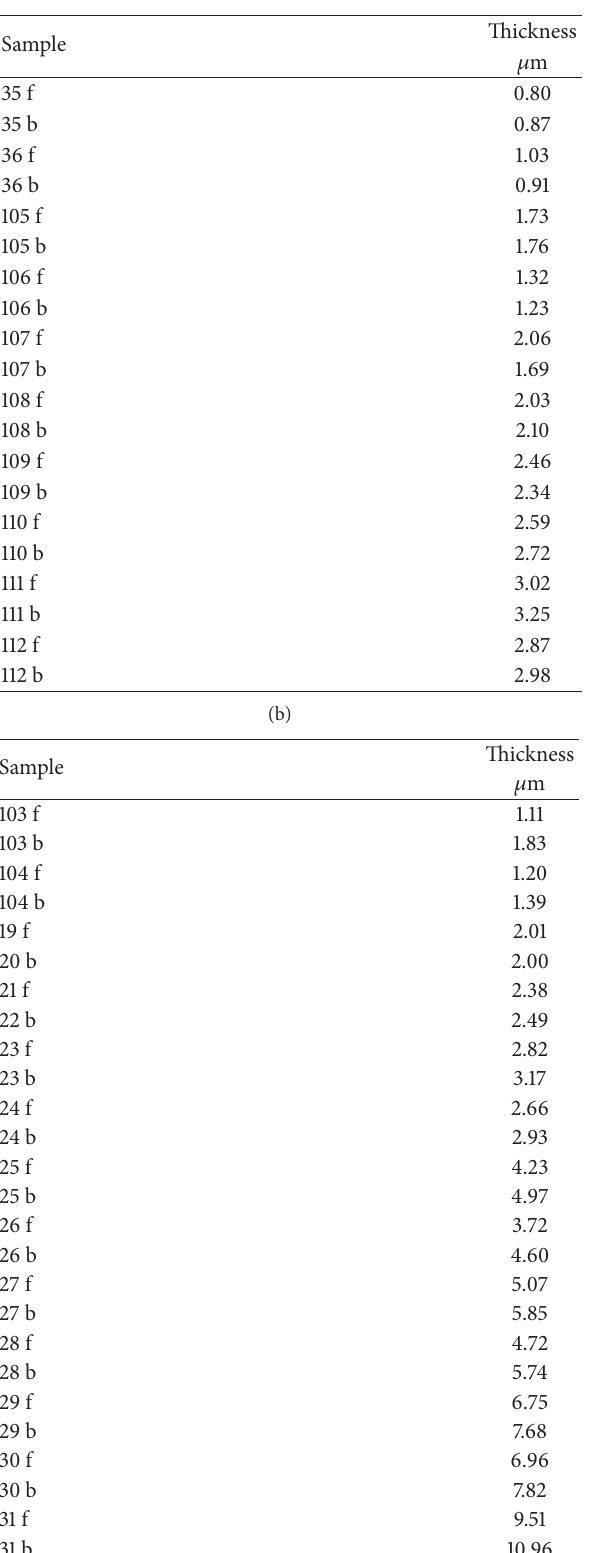
Table 1: List of the investigated samples: (a) Wood bath and (b) Wood + Watts baths. f: sample front face; b: sample back face.